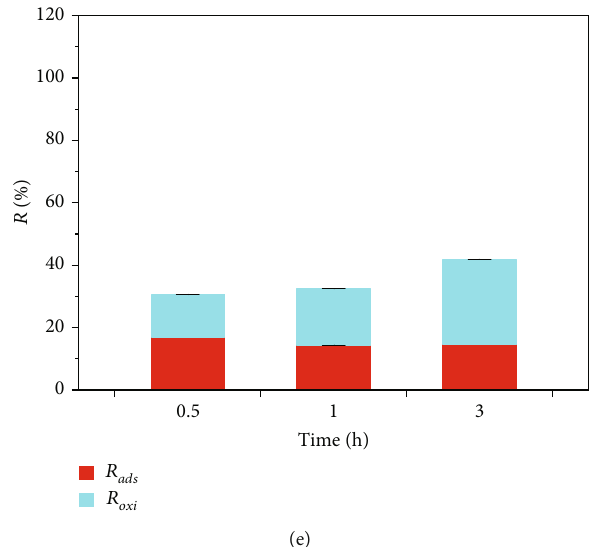
R and R δ -MnO at 0.5h, 1 h, and 3h, under the conditions of pH 2.00 (b), 4.01 ads oxi of MB in 2